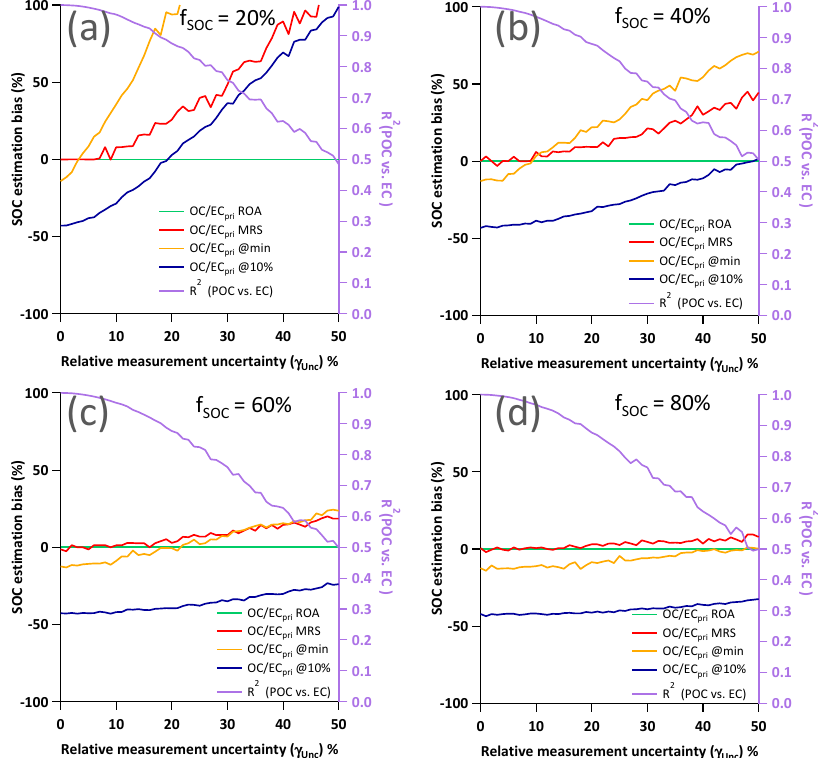
Figure 7. Bias of SOC determination as a function of relative measurement uncertainty ( γ unc ) and SOC / OC ratio ( f SOC ) by different approaches of estimating (OC / EC) pri , including ratio of averages (ROA), minimum R squared (MRS), OC / EC 10 % , and OC / EC min . Fixed input parameters: n = 8000, EC = 2 ± 1µgCm − 3 , (OC / EC) pri = 0 . 5. Variable input parameters: (a) f SOC = 20%, SOC = 0 . 25 ± 0 . 13µgCm − 3 , (b) f SOC = 40%, SOC = 0.67 ± 0.33µgCm − 3 , (c) f SOC = 60%, SOC = 1 . 5 ± 0 . 75µgCm − 3 , and (d) f SOC = 80%, SOC = 4 ± 2µgCm − 3